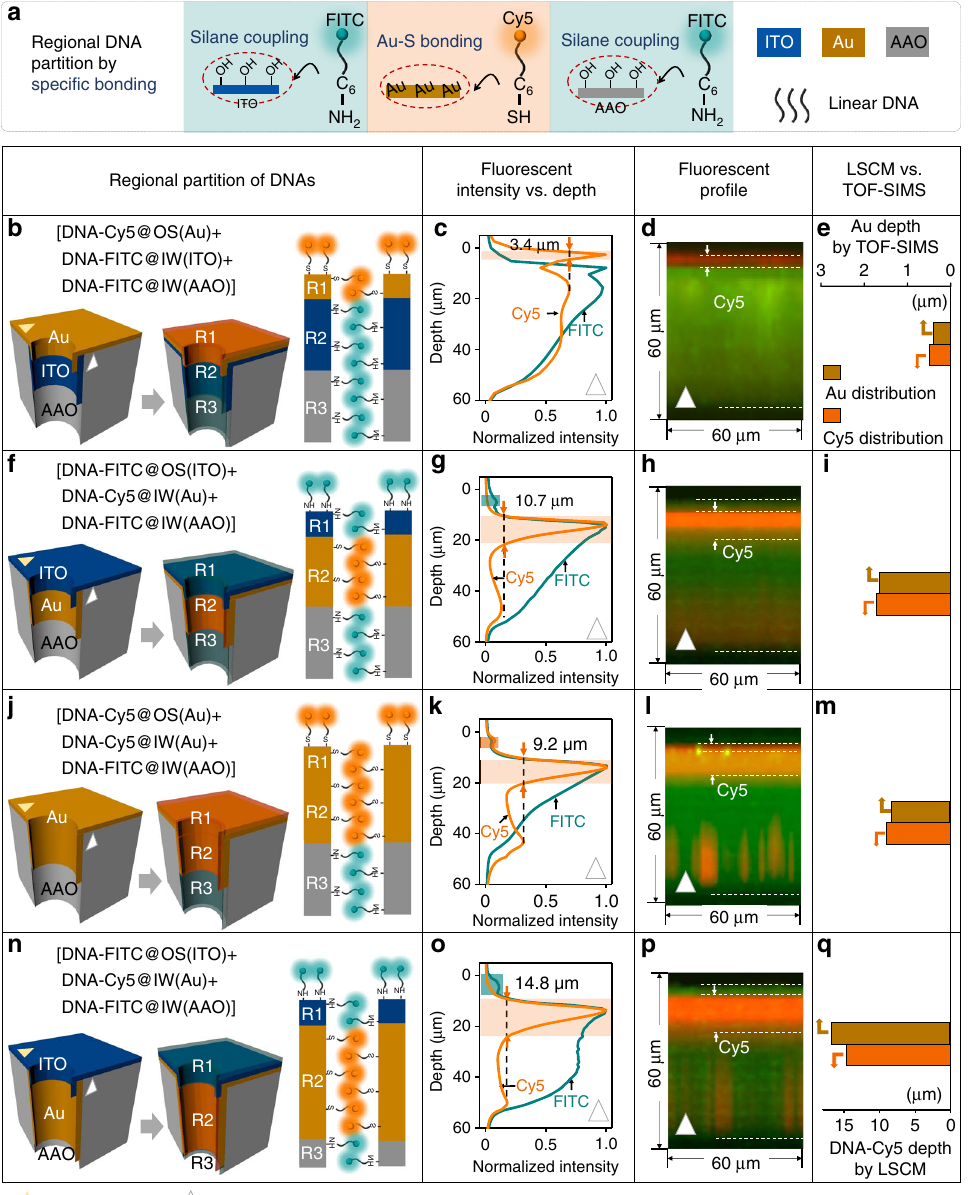
Fig. 3 Explicit partition of FE IW and FE OS . a DNA labeled with FITC or Cy5 are bonded at ITO, Au and AAO surface using silane coupling, Au-S bonding and silane coupling, respectively. Schematics ( b , f , j , n ) described the varied modi fi cation labeled DNA at the OS and IW of four samples which are introduced in Fig. 2a – m, respectively. The intensity distributions of fl uorescence along the depth of AAO membrane are listed in c , g , k , o , respectively. The red lines and green lines represent the DNA with Cy5 and the DNA with FITC, respectively, based on the Z-axil of LSCMs for the four samples ( d , h , l , p ). e , i , m , q Comparison between the Au depth (gold) measured by TOF-SIMS and the DNA-Cy5 (red) depth measured by